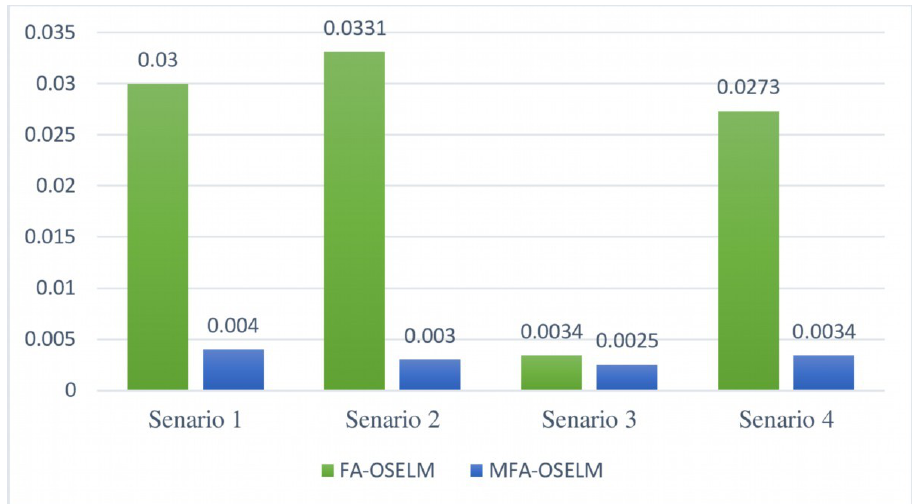
Figure 10. Standard deviations of model signal accuracy obtained using MFA-OSELM and FA-OSELM for the UJIIndoorLoc dataset.